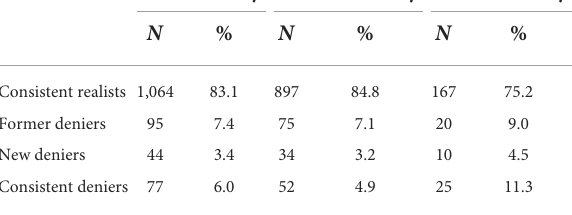
TABLE 1 Dynamics in Corona conspiracy beliefs in East and West